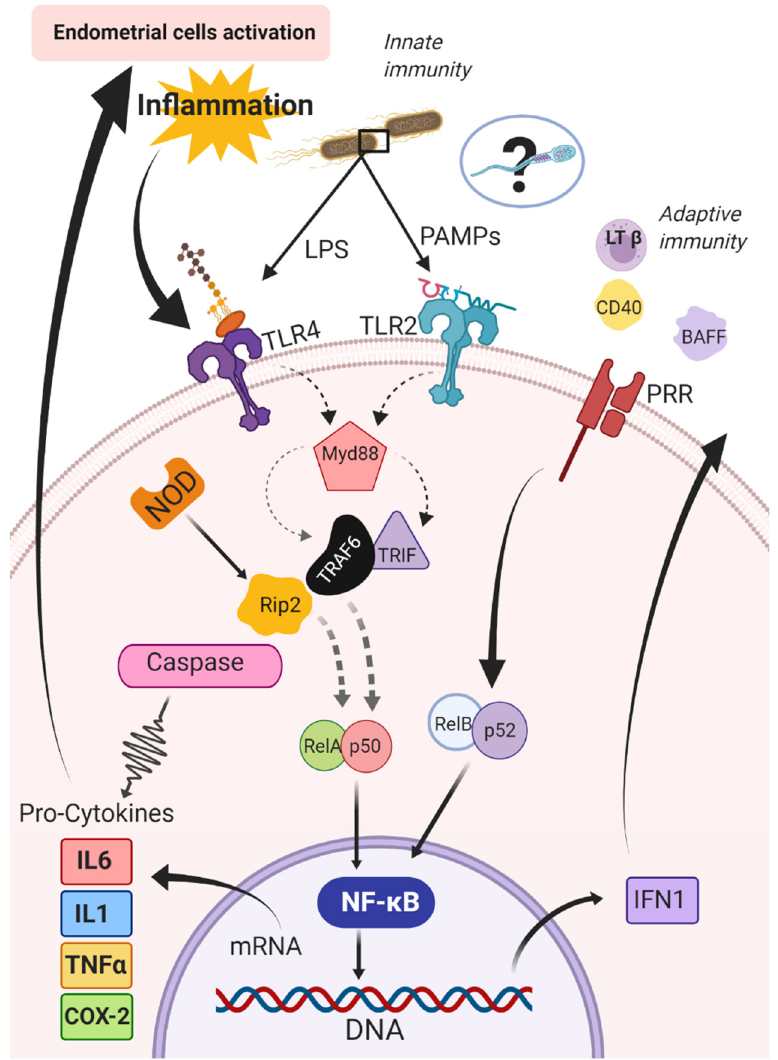
Figure 2. Canonic and alternative pathways for activation of the nuclear factor kappa beta (NF-kB) in the endometrium of mares. BAFF: B cell activating Factor; CD40: Cluster of di ff erentiation 40; COX-2: cyclooxygenase-2; IFN1: type 1 interferons; IL1: interleukin 1; IL6: interleukin 6; LPS: lipopolysaccharides; LT β : lymphotoxin β ; MyD88: Myeloid di ff erentiation primary response 88; NF- κ B: nuclear factor kappa beta; NOD: nucleotide-binding and oligomerization domain; PAMPs: pathogen-associated molecular patterns; PRR: pattern recognition receptors; RelA / p50 and RelB / p52: subunits of the NF- κ B complex; Rip2: receptor-interacting protein 2; TLR2: Toll-like receptors type 2; TLR4: Toll-like receptors type 4; TNF α : tumor necrosis factor-alpha; TRIF: TIR-domain-containing adapter-inducing interferon- β ; TRAF6: receptor-associated factor 6.